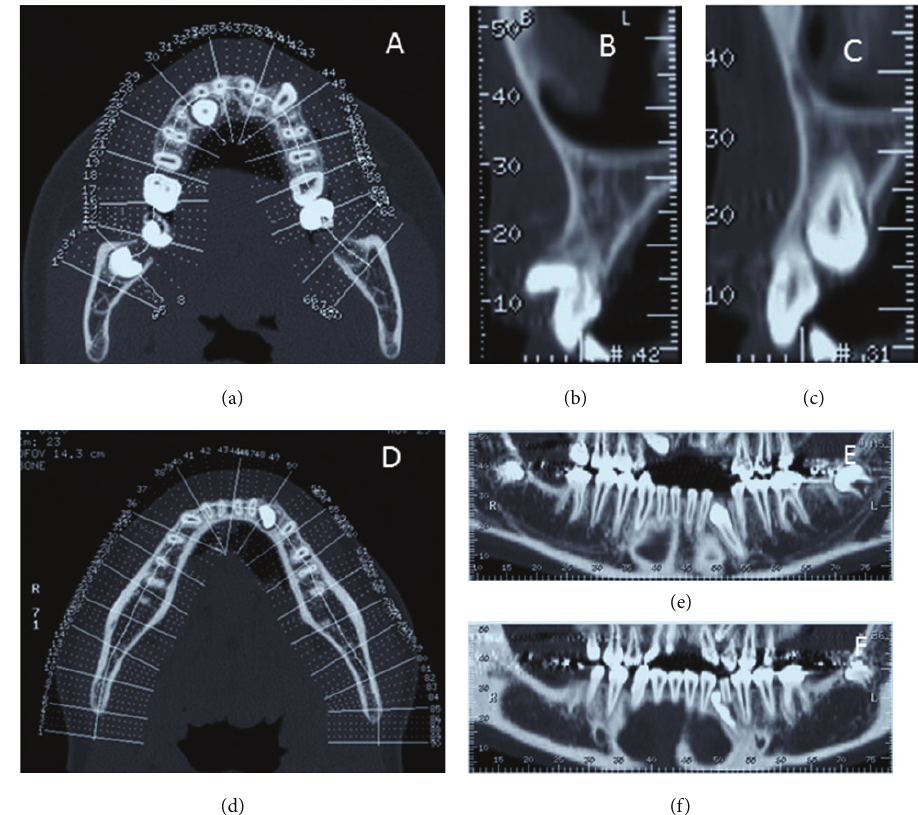
Figure 3: CT scan showing the axial (a) and the sagittal ((b), (c)) view of the maxillary impacted canine and the axial and frontal view of the mandibular canine ((d), (e),